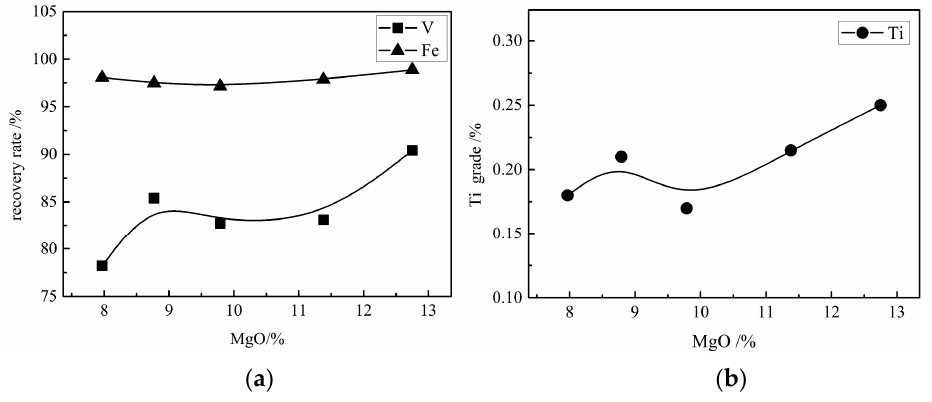
Figure 12. ( a ) Effects of MgO on Fe and V recovery rates; and ( b ) effects of MgO on the Ti grade in iron.